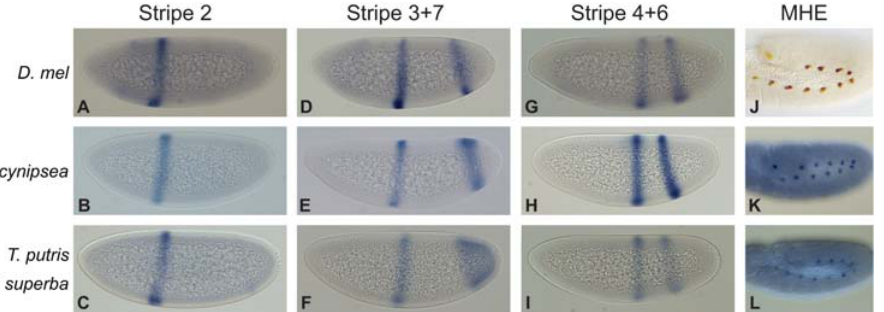
Figure 5. Sepsid eve enhancers drive conserved expression patterns in Drosophilamelanogaster embryos. Expression patterns of eve stripe 2, stripe 3 + 7, stripe 4 + 6 and muscle-heart enhancers from sepsids S. cynipsea , T. putris and T. superba were compared to their D. melanogaster counterparts in transgenic D. melanogaster embryos by RNA in situ hybridization with digoxigenin-labeled antisense RNA probes against the reporter genes lacZ (A, D, G) and CFP (B,C,E,F,H,I,K,L), or staining with b Gal antibodies (J). (A–C) Sepsid stripe 2 enhancers drive strong expression in an anterior stripe corresponding to D. melanogaster stripe 2. (D–F) Sepsid stripe 3 + 7 enhancers drive expression within the limits of D. melanogaster stripe 3 and 7, with additional expression in the posterior. (G–I) Sepsid stripe 4 + 6 enhancers drive expression within the limits of D. melanogaster stripes 4 and 6. (J–L) Sepsid MHE enhancers are expressed in metameric clusters in the dorsal mesoderm in stage, as in D. melanogaster . Embryos were imaged during cellularization and are oriented with anterior to the left and dorsal up.